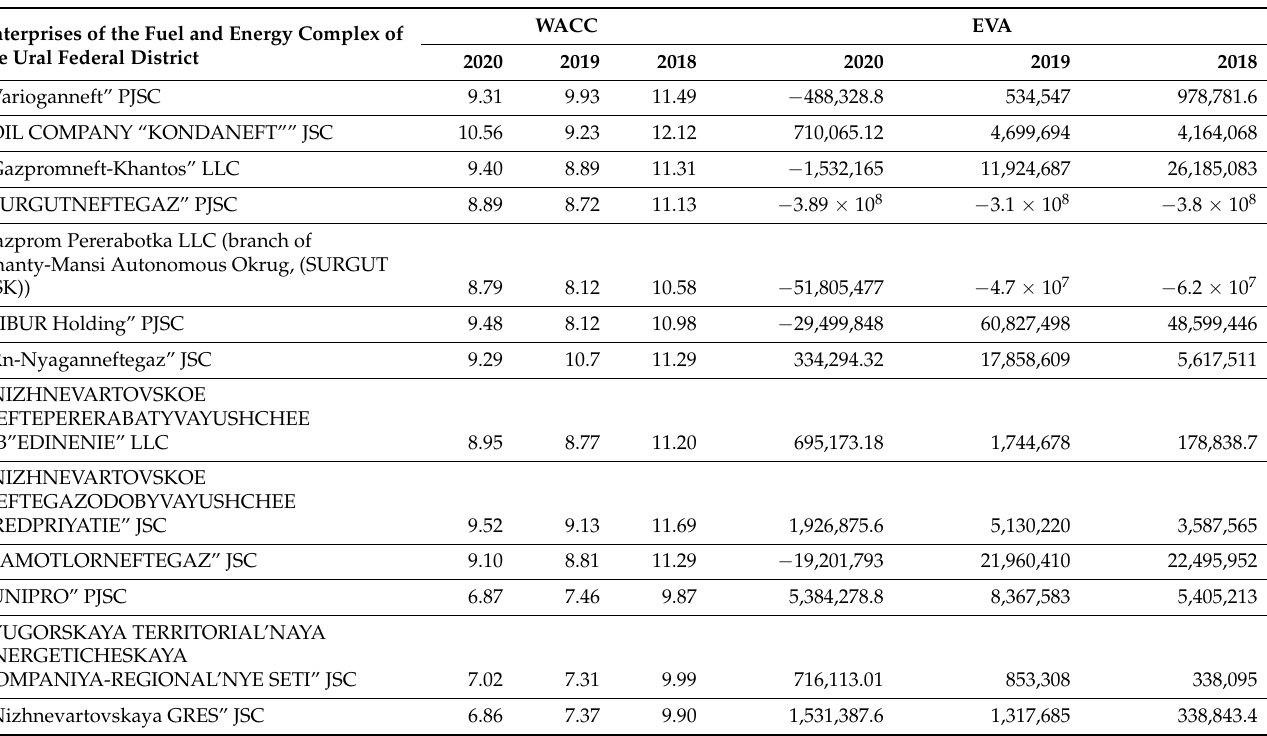
Figure 1. Multipliers: a study of the investment attractiveness of industrial enterprises and the level of investment risk. EVA—absolute indicator, plays a supporting role. Source: developed by Zadimidchenko A. EVA—Economic value added. EBITDA—Earnings Before Interest, Taxes, Depreciation, and Amortization. ROIC—Return on capital, or return on invested capital. ROE—Return on equity. Debt—Debt is a deferred payment, or series of payments, which differentiates it from an immediate purchase. Table 1. Measurement of the investment attractiveness of enterprises in the industrial complex of the fuel and energy complex of the Ural Federal District based on the assessment of WACC and EVA indicators (table